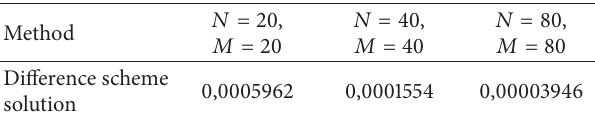
Table 1: Errors for the approximate solutions of problem